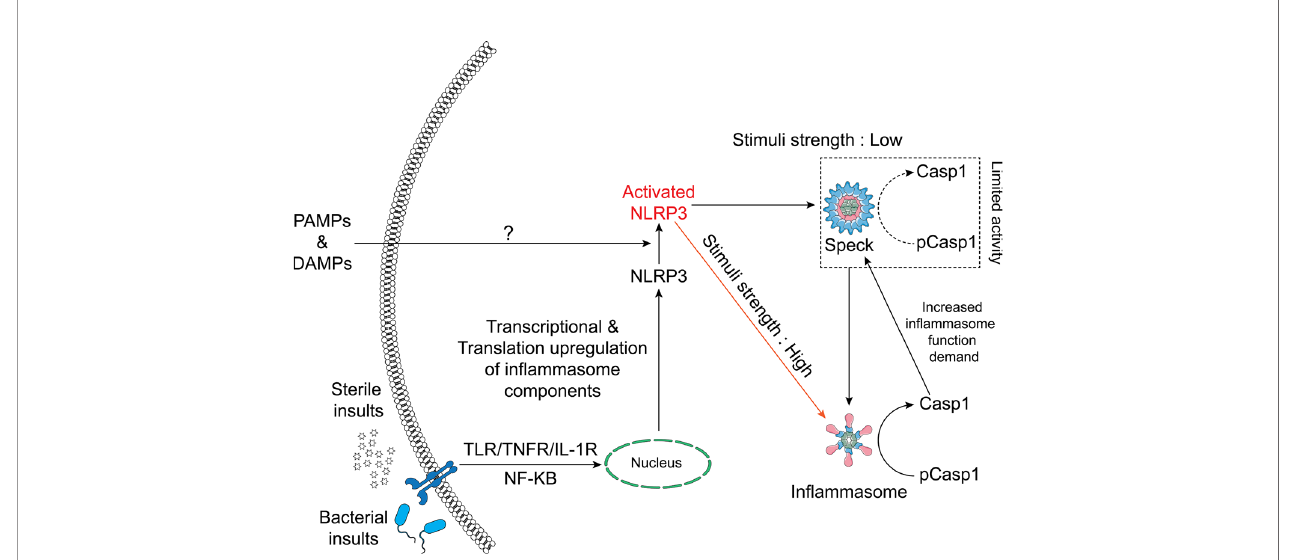
FIGURE 7 | Schematic of the relationship between the NLRP3 in fl ammasome and speck. NLRP3 – ASC specks form by rapid relocation of these proteins into a perinuclear toroidal structure. Specks allow in fl ammasome complexes to be activated at a lower stimulus threshold and thus facilitate an optimal in fl ammasome response to weaker signals. However, in fl ammasome complexes also form independently of the speck and stronger signals may not require or elicit speck formation. The speck likely sheds small in fl ammasome complexes where caspase-1 becomes active. As caspase-1 activity regulates the size of the speck, active caspase-1 may facilitate the release of small in fl ammasome complexes, acting as an intracellular feedforward loop maximizing IL-1 b